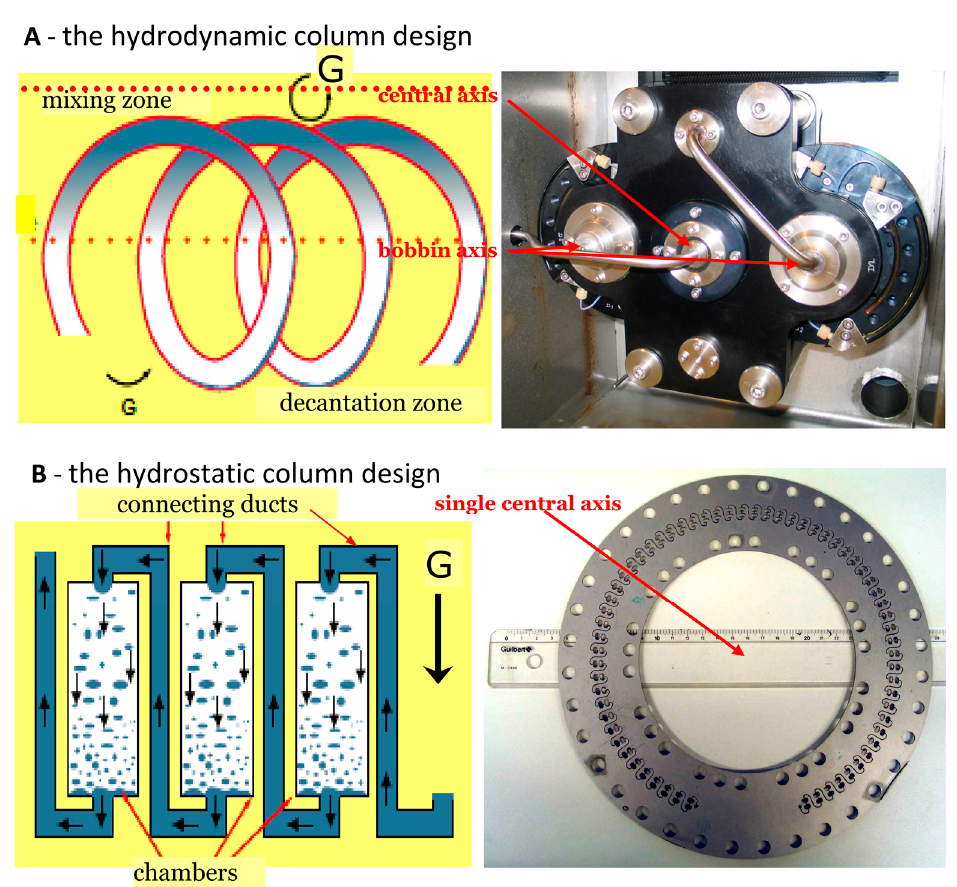
Figure 1. Countercurrent chromatography (CCC) column designs. ( A ) The hydrodynamic design combining bobbin and rotor rotation to obtain a planetary motion generating a variable centrifugal field with mixing and decantation zones. The Spectrum two-bobbin rotor of the Dynamic Extraction hydrodynamic column is shown on the right. ( B ) The hydrostatic design with interconnected simple rectangular chambers (left). An actual disk from a modern Kromaton FCPC-C hydrostatic column is shown on the right with its patented dual-cell design (64 dual cells in a disk).